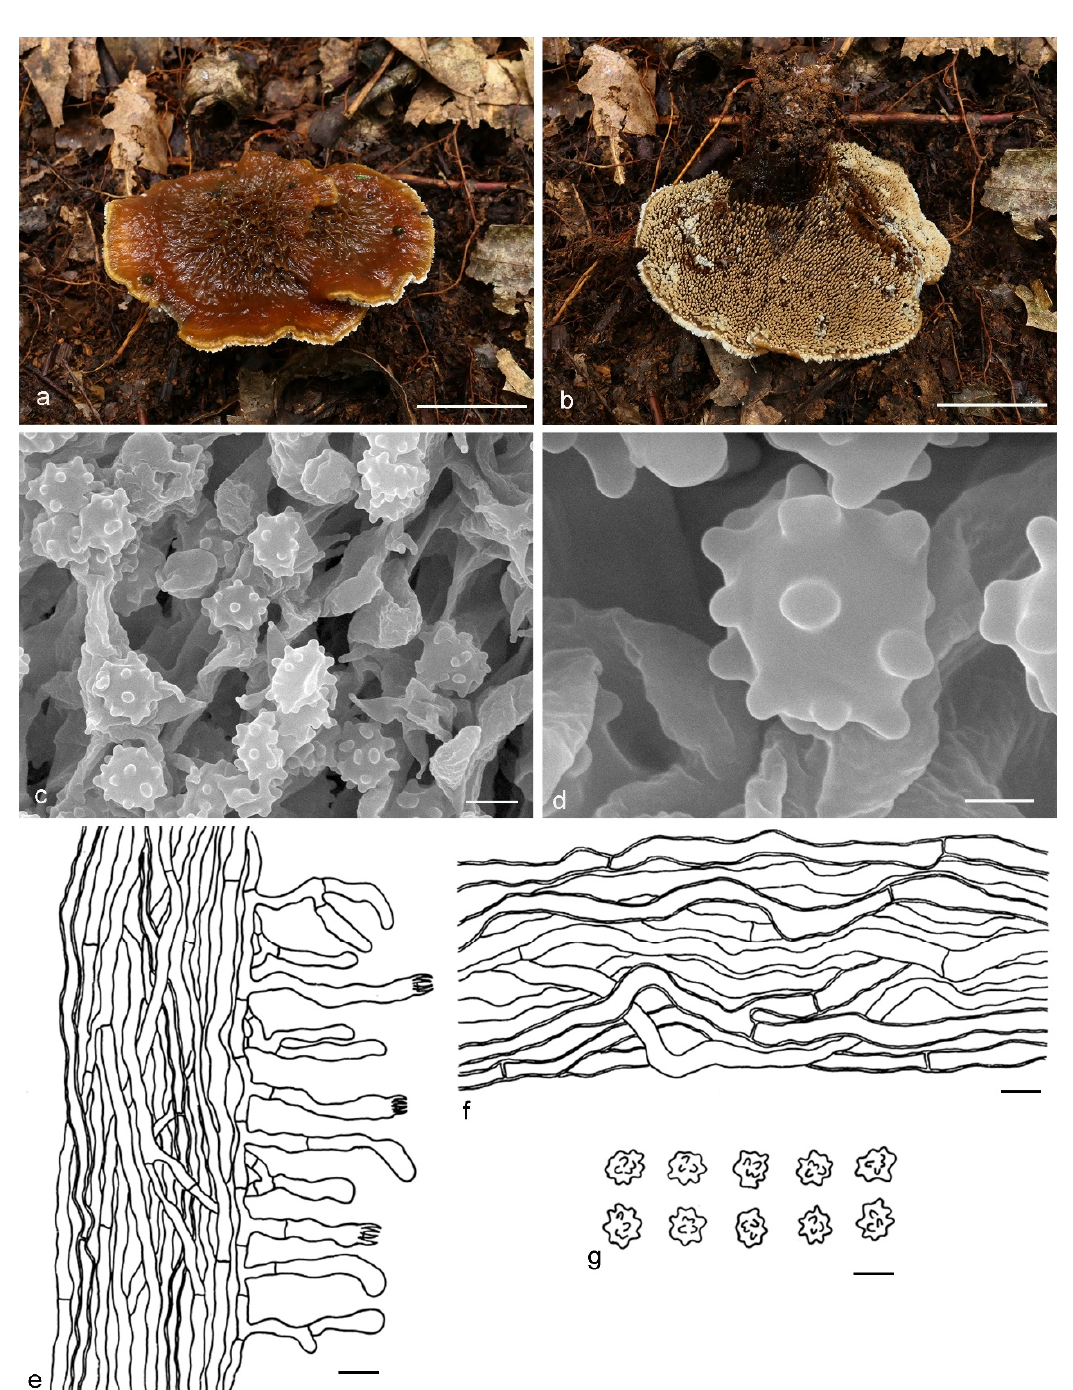
Figure 6. Hydnellum inflatum. ( a , b ): Basidiocarps; ( c , d ): SEM of basidiospores; ( e – g ): Microscopic structures (drawn from IFP 019403); ( e ): Section of hymenophore trama with basidia; ( f ): Hyphae from pileus context; ( g ): Basidiospores. —Scale bars: ( a , b ) = 1 cm; ( c ) = 3 μm; ( d ) = 1 μm; ( e , f ) = 10 μm; ( g ) = 5 μm.